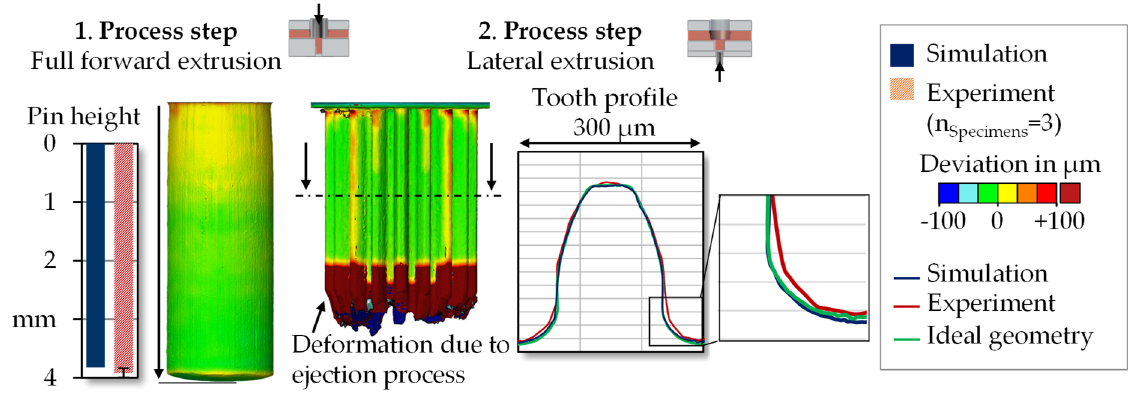
Figure 5. Comparison of component geometry in simulation and experiment.